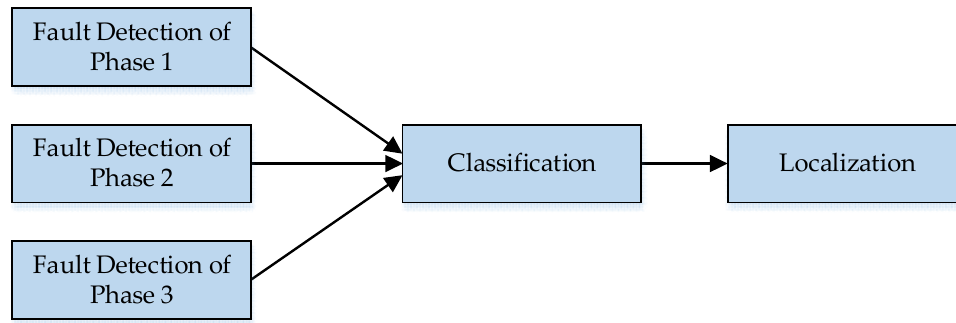
Figure 4. Steps in fault-monitoring systems. Any combination of faults in line phases could